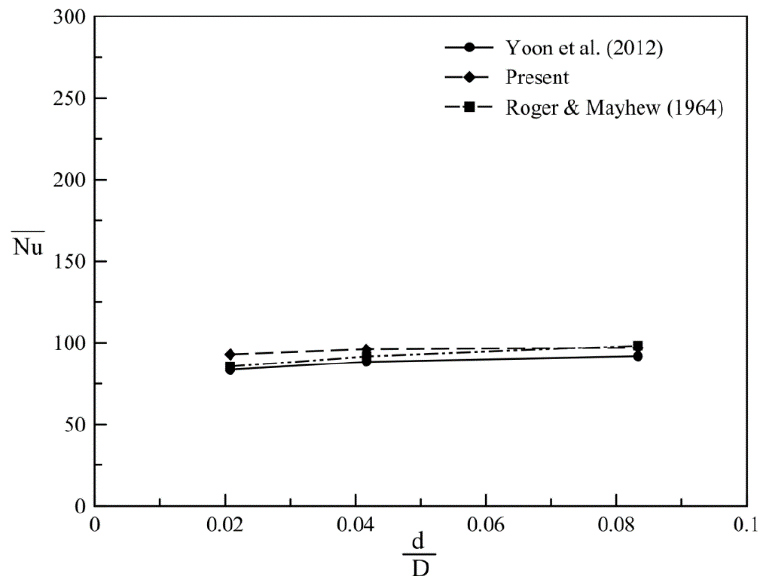
Figure 7. Average Nusselt number for different d/D values at Re = 25,000.